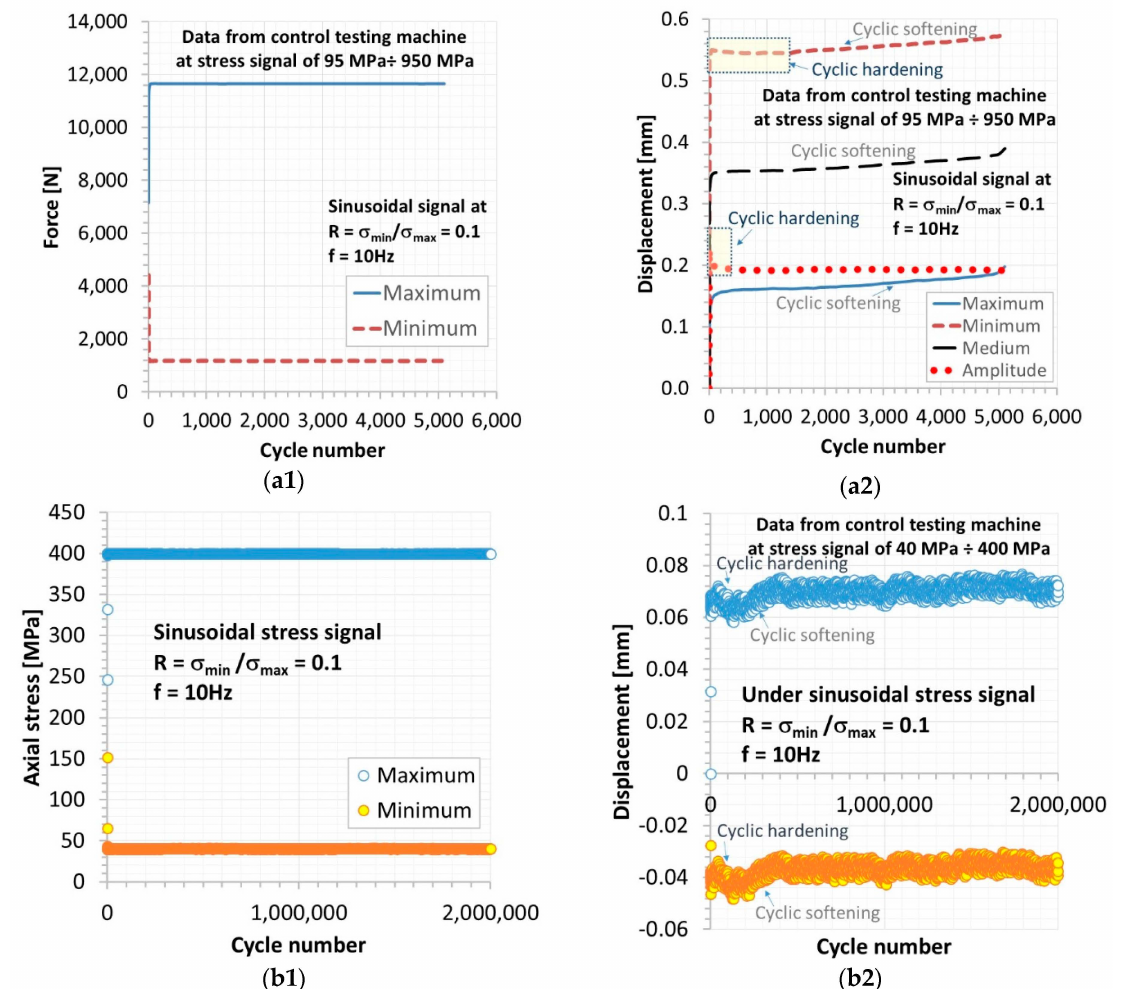
Figure 3. Maximum and minimum values of force ( a1 ) and stress signal ( b1 ) and displacement ( a2 , b2 ) from the fatigue test for determining fatigue limit of S700MC steel welded by means of the welding wire of Union X96, reaching 5 × 10 3 ( a1 , a2 ) and 2 × 10 6 cycles ( b1 , b2 ).